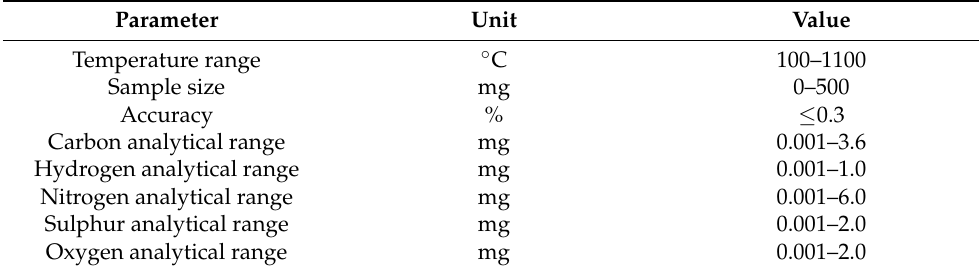
Table 4. Technical specifications of the PerkinElmer CHNS/0 2400